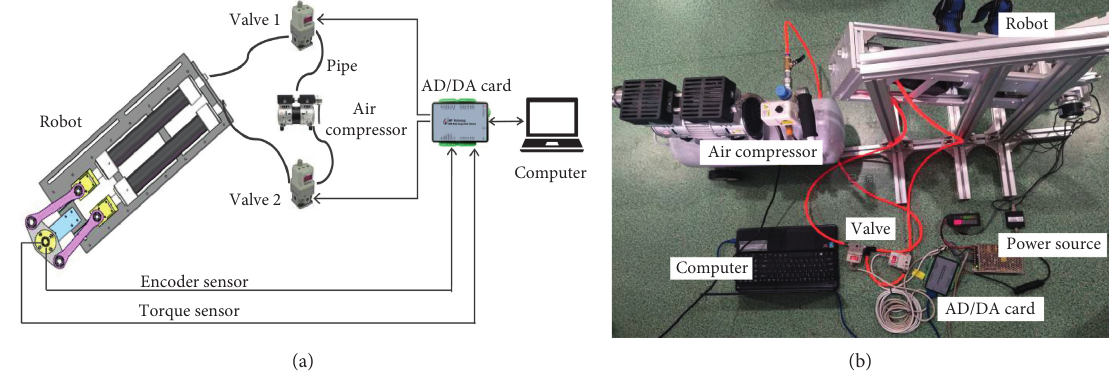
Figure 9: The PMAs driven rehabilitation ankle robot: (a) schematic drawing; (b) prototype of the experimental setup.